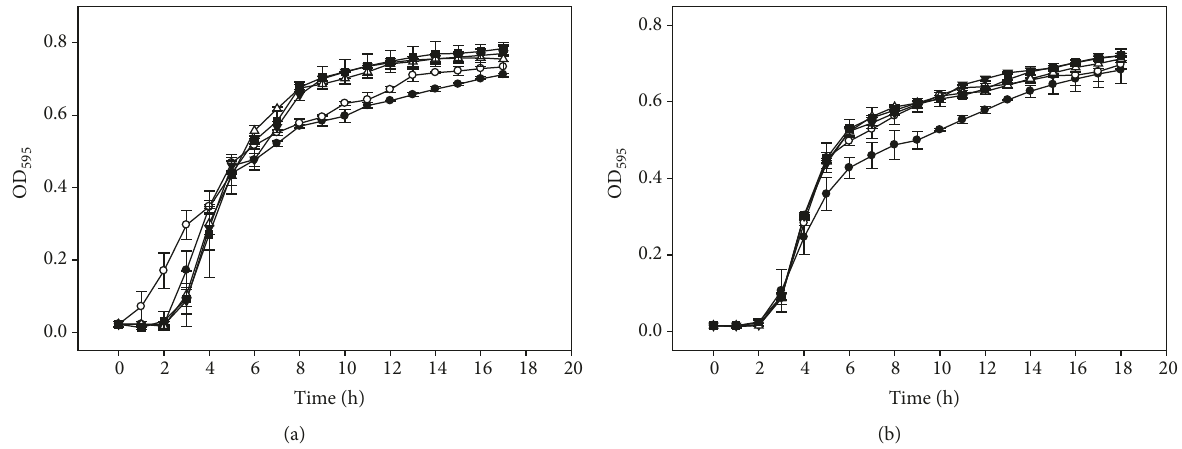
Figure 3: Benzoyl peroxide (a) and salicylic acid (b) activity against E. coli . Benzoyl peroxide 250 𝜇 g/mL ( e ), 125 𝜇 g/mL ( I ), 62.5 𝜇 g/mL ( 󳶃 ), 31.3 𝜇 g/mL ( Δ ), and 0 𝜇 g/mL ( ◼ ). Salicylic acid 250 𝜇 g/mL ( e ), 125 𝜇 g/mL ( I ), 62.5 𝜇 g/mL ( 󳶃 ), 31.3 𝜇 g/mL ( Δ ), and 0 𝜇 g/mL ( ◼ ).